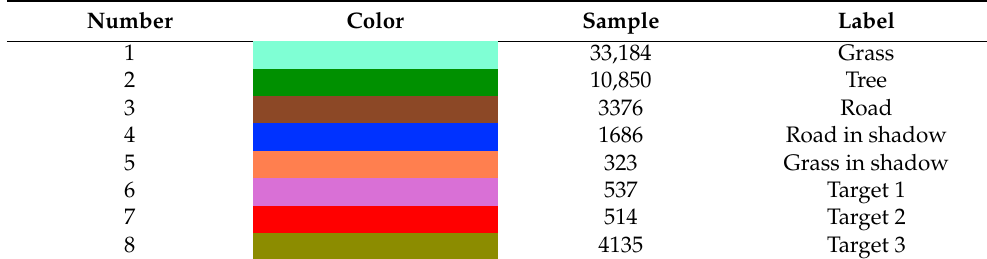
Figure 9. The original HYDICE and ground truth. ( a ) HYDICE. ( b ) Ground truth. Table 1. Information of the ground truth. The labels, sample number, and represented colors for each category in the ground truth are